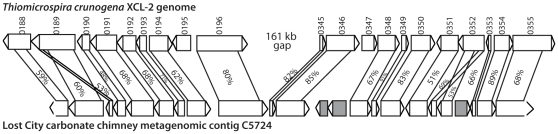
Conservation of gene order (synteny) between open reading frames (ORFs) in the T. crunogena genome (top) and the largest Lost City chimney metagenomic contig (bottom).The Lost City contig has putative homologs in two distinct regions of the T. crunogena genome separated by 161 kb. Amino acid identities and alignment lengths (as calculated by blastp) are shown. T. crunogena ORFs Tcr_0189 and Tcr_0352 each appear to be fusions of two Lost City ORFs. The three Lost City ORFs shaded gray are more similar to proteins from other bacteria including Methylophaga and Marinobacter and are in reverse orientation with respect to nearby ORFs. Accession number for contig C5724 is ACQI01005724.